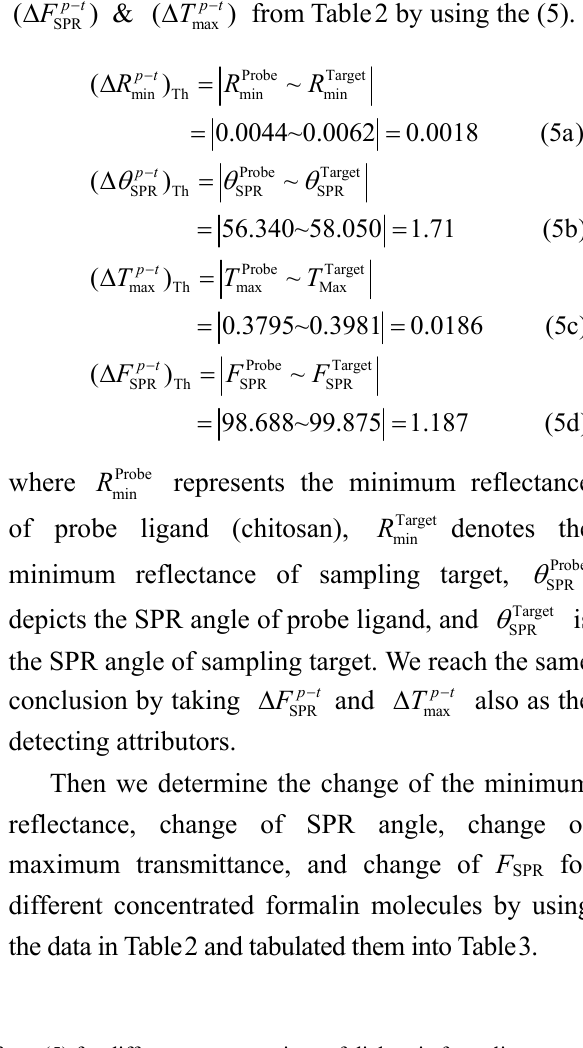
values from (5) for different concentrations of dielectric formalin.